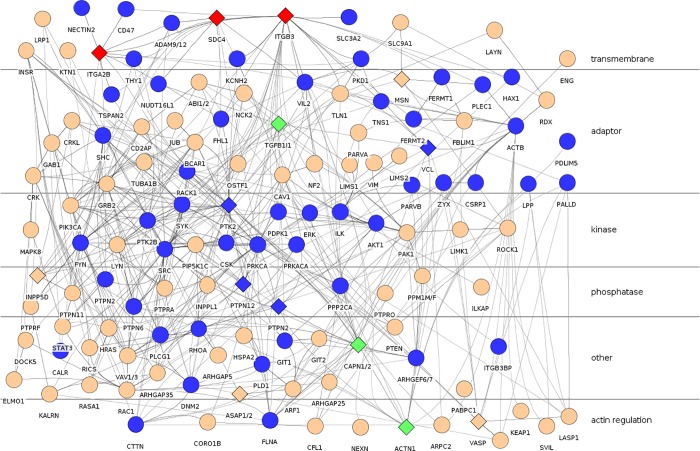
Platelet integrin adhesome highlighting proteins containing bioactive peptides.Diamonds represent proteins from which peptides were derived. Red: proteins from which active palmitylated peptides were derived. Green: proteins from which active tat peptides were derived. Circles: other proteins. Edges represent interactions annotated in the integrin adhesome [2], and inferred homologous interactions.